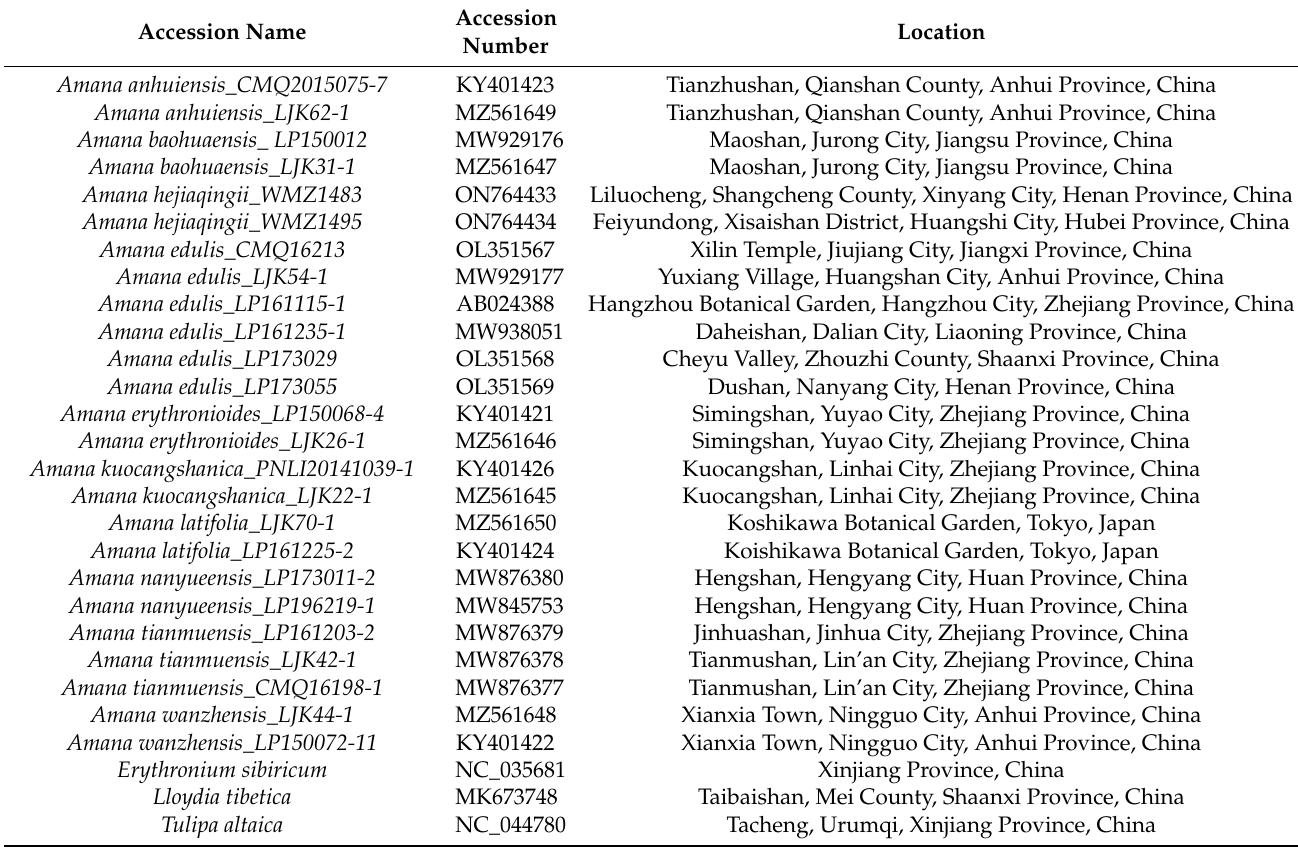
Table 1. The plastome sequences of Amana accessions used in this